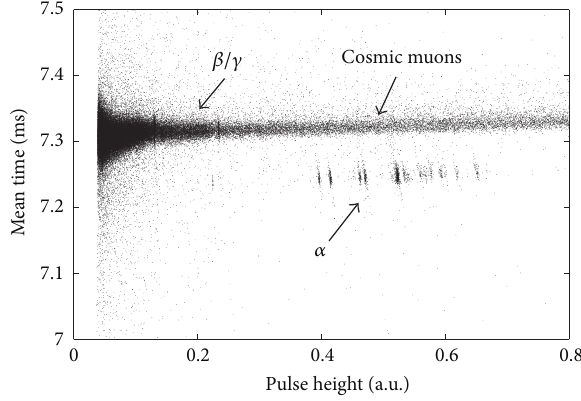
Figure 3: A scatter plot of the mean-time and pulse height obtained from the background measurement of 95 h in an overground laboratory. 𝛼 and 𝛽/𝛾 (including cosmic muons) events are clearly separated in terms of their mean-time